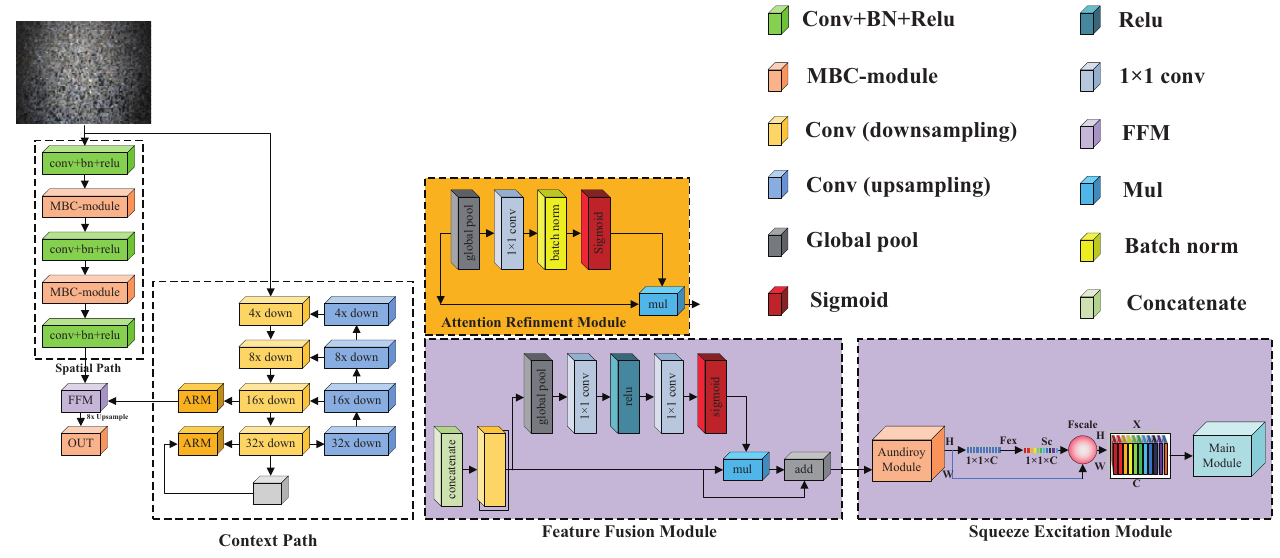
Figure 4. Block diagram of semantic segmentation network. This module mainly includes four parts: context path, attention refinement module, feature fusion module and squeeze excitation